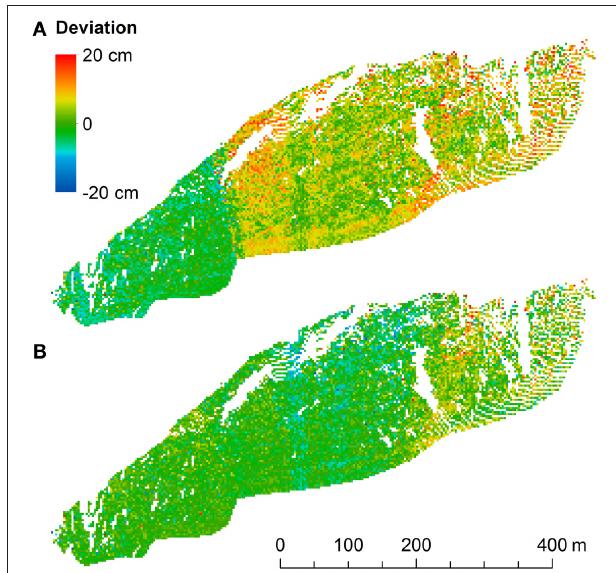
FIGURE 3 | Errors between fine and coarse scans (A) before and (B) after MSA. (A) The boundary between two of the fine scans is visible as a sharp transition of the error. (B) MSA reduced the registration errors (systematic error). Note, however, that there are still some spatial patterns in the errors. The case of 21 March is shown. The orientation of the rock face is similar to the view in Figure 1B